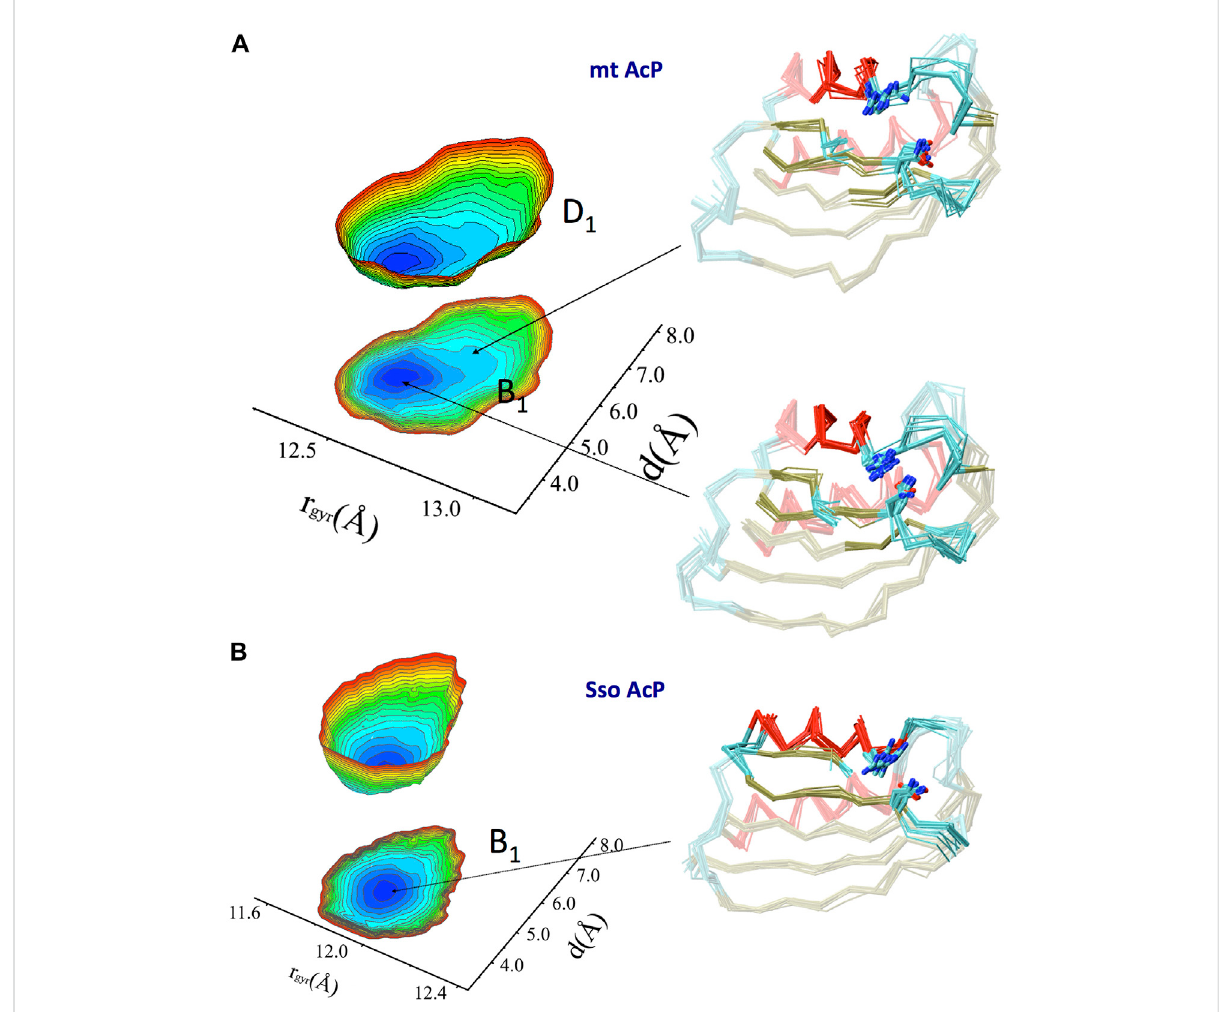
FIGURE 3 Native freeenergy surfaces of mt AcP andSso AcP. (A) FES ofmt AcP at37 ° C calculated using RDC-derivedstructuralensembleprojected onto two reaction coordinates. These are the protein radius of gyration (rgyr) of the entire protein (global coordinate) and the distance between the catalytic residues Arg 23 and Asn 41 (local coordinate). The FES is plotted either as 3D surface or projection onto the 2D plane. Representative structural bundles are shown for the main basin B1 and a distorted conformation D1 that is thermally accessible within the native state of the protein. Colour codes for the C α -traces are as in Figure 2B. Arg 23 and Asn 41 are explicitly drawn on the protein ensemble. The free energy difference between the lowest (blue) and highest (red) points of the surface is 10 kJ/mol, whereas the free energy difference between the indicated B1 and D1 basins is 2.2 kJ/mol. (B) FES of SsoAcP at 80 ° C. Details as in panel